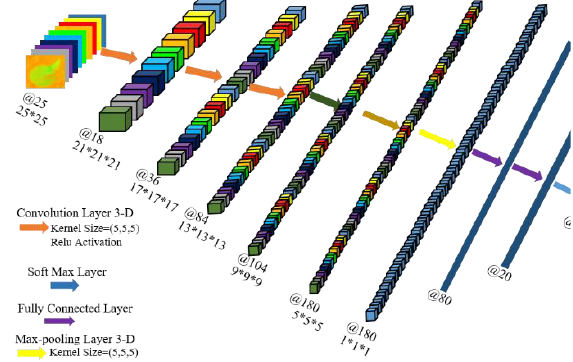
Fig. 2. The architecture of proposed 3D-CNN for binary change detection.